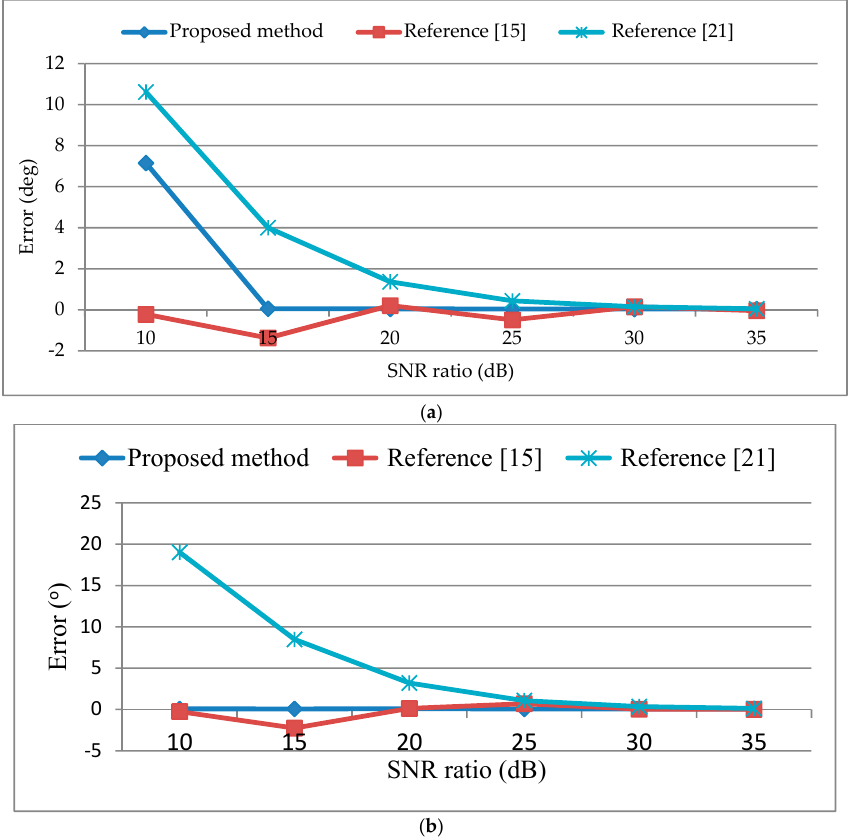
Figure 14. Rotation errors for the matching results with Gaussian noise. ( a ) The case of Figure 13(a); ( b ) The case of Figure